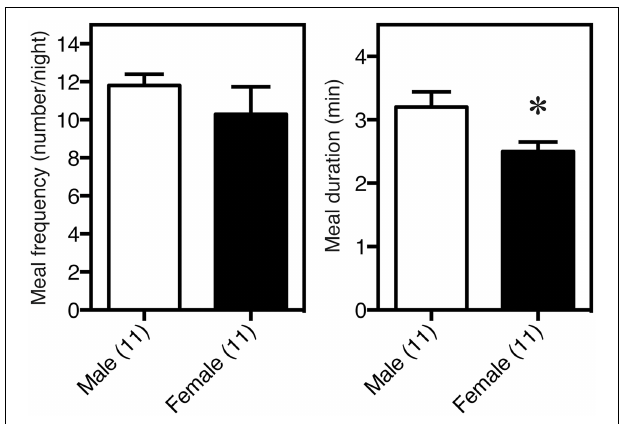
FIGURE 2 | Sex difference in feeding behavior, determined with an automated feeding pattern analyzer. Meal duration, but not frequency, was significantly shorter in females than in males. * P < 0 . 05 .